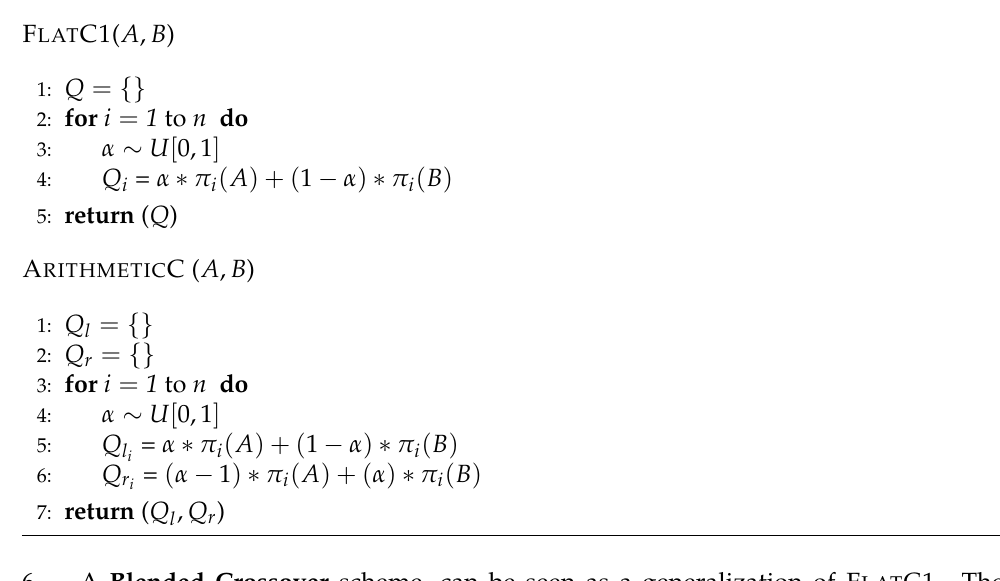
Algorithm 6 Flat and Arithmetic Crossover-S HUFFLE C1, A RITHMETIC